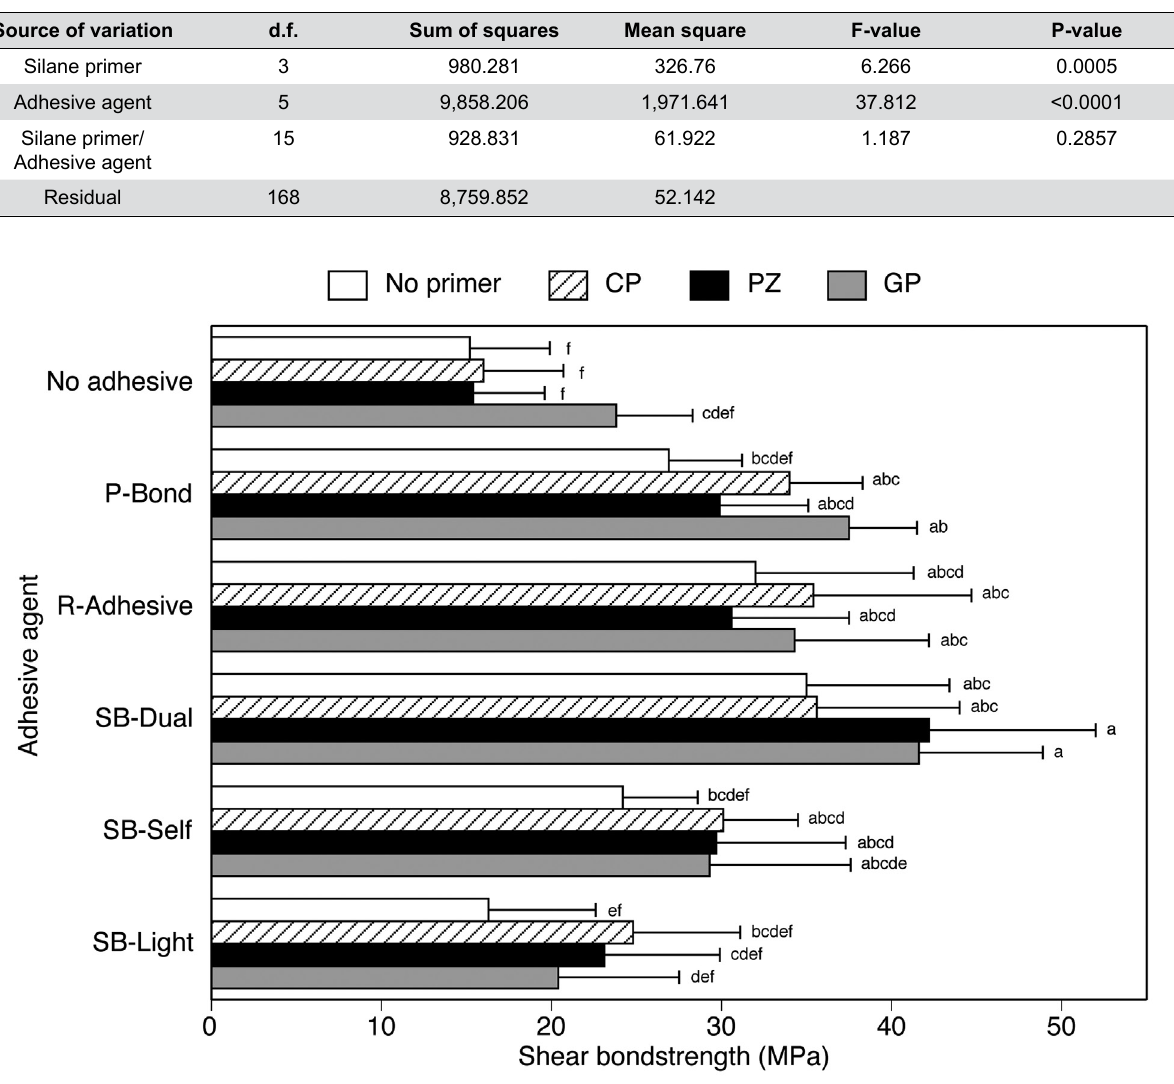
Figure 3- Results of shear bond testing. Identical letters (a, b, c, d, e, f) indicate that the difference between values is not statistically significant